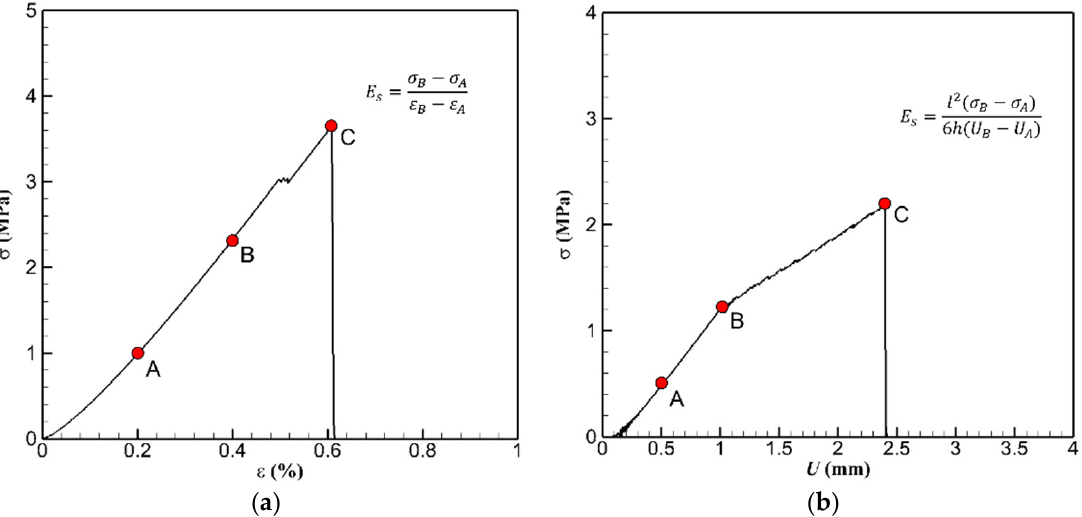
Figure 8. Simulated stress–strain/deformation curves: ( a ) uniaxial compressive test; ( b ) three-point bending test.